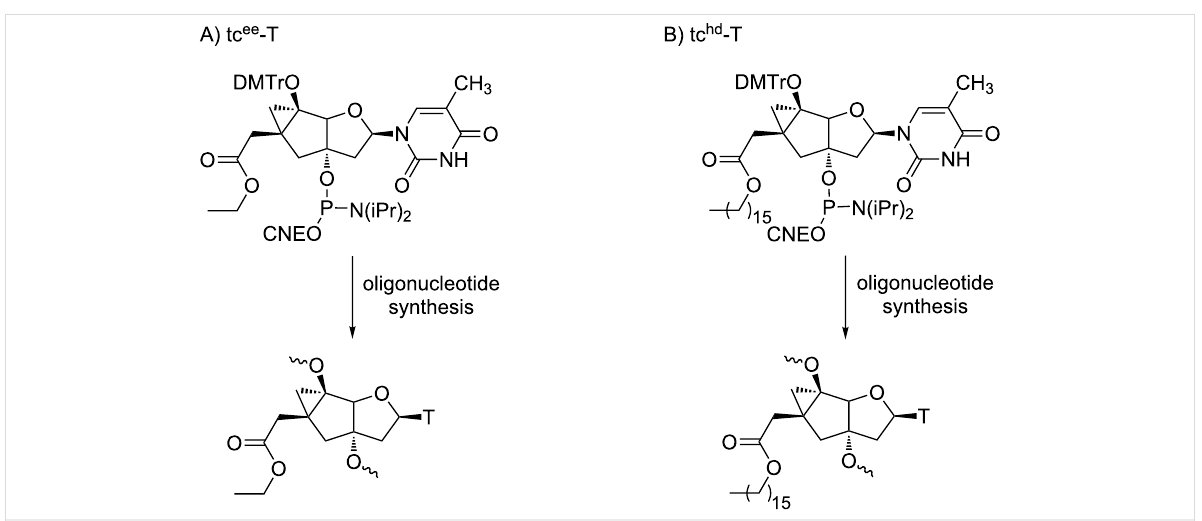
Scheme 12: Prodrugs of tricyclo-ONs functionalized with A) ethyl (tc ee -T) and B) hexadecyl (tc hd -T) ester functions at C6 obtained from correspond- ing thymidine phosphoramidites